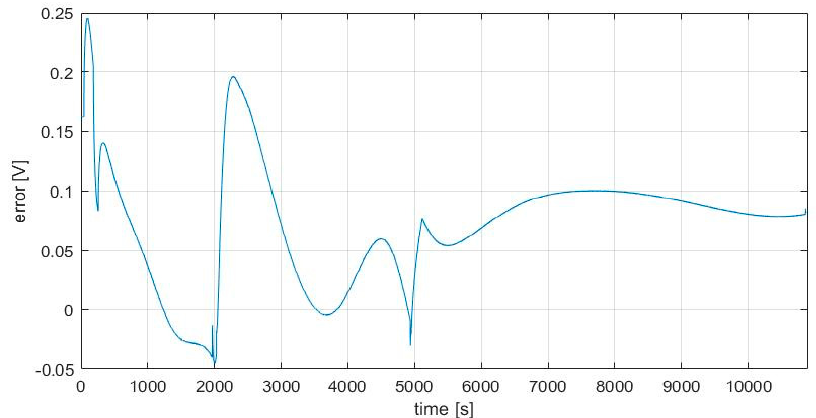
Figure 19. Di ff erence between the measured voltage and simulated Figure 19. Difference between the measured voltage and simulated voltage.